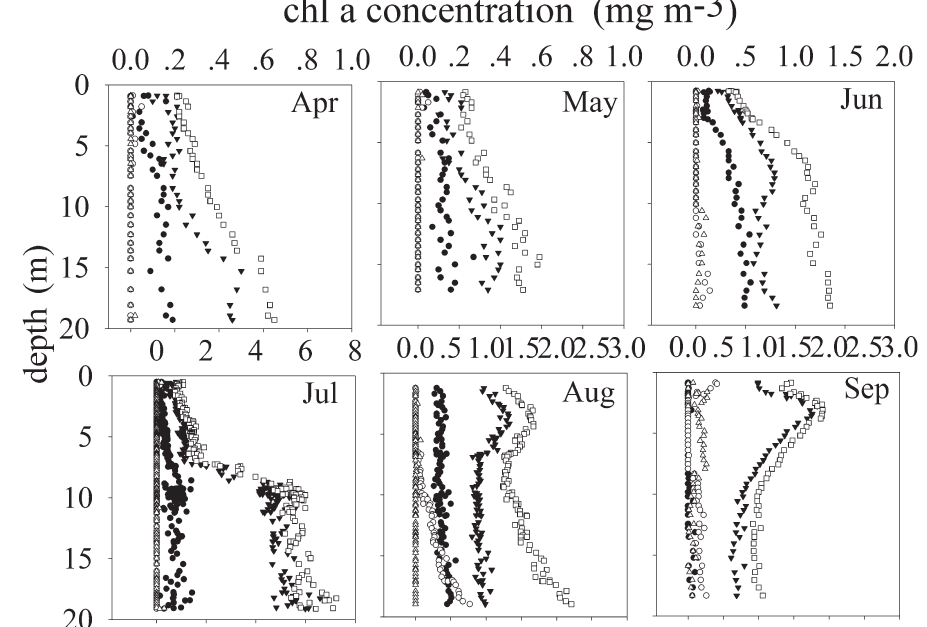
Fig . 4. – Vertical profiles of green algae (circles), cyanobacteria (empty-circles), diatoms and dinoflagellates (down-triangles), cryptophyta (up-triangles), and total chlorophyll a concentration(squares) at fixed station S03 from April to September in Sanya